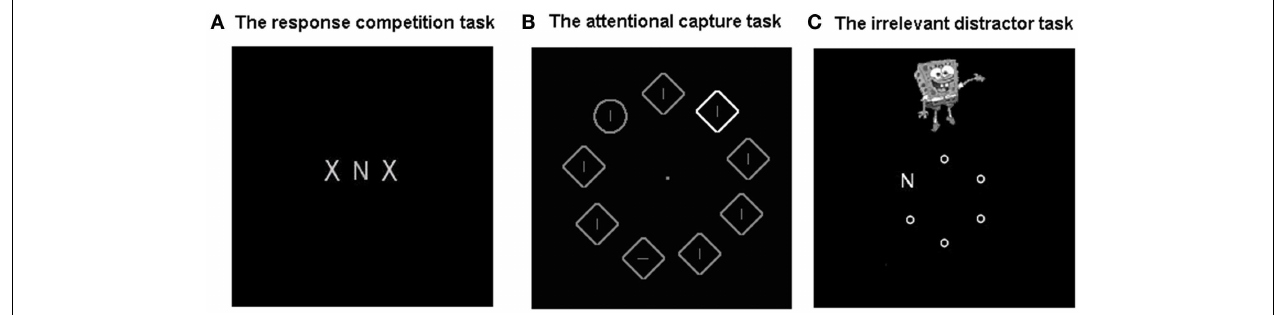
non-target search items appears as a salient singleton in an irrelevant dimension (e.g., color), compared to a no singleton baseline. (C) A new measure of interference from salient yet entirely task-irrelevant distractors. Within these measures distraction is indexed by the increase in RTs associated with the peripheral presentation of a colorful distractor.This can be either an image of a well known cartoon character (selected from Superman, Spiderman, Pikachu, Spongebob Squarepants, Micky Mouse, and Donald Duck) or meaningless yet colorful